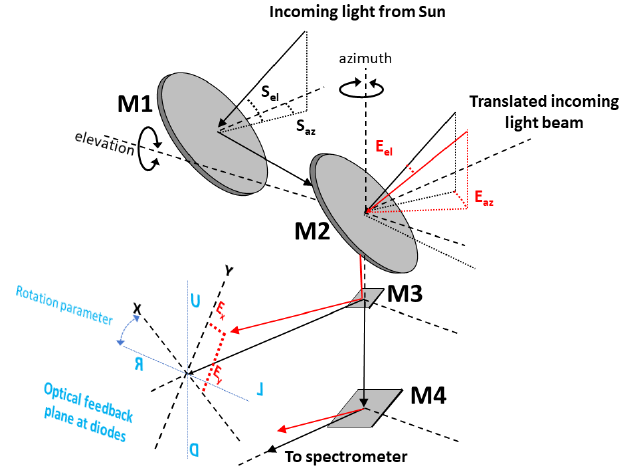
Figure 4. Geometry of the Lauder solar tracker optics for the sim- plest configuration. Focus optics are not shown. M1 and M2 are the tracker ALT-AZ mirrors. M3 is a small flat mirror to direct a por- tion of the incoming beam to the optical feedback system. M4 is a large flat mirror directing the solar beam into the spectrometer. ( Sel , Saz ) is the calculated (solar-pointing) incoming beam vector. X – Y is the planar coordinate system of the optical feedback sys- tem, shown here prior to correction with the installation-specific ro- tation parameter. ( Ex , Ey ) is the mispointing vector. ( Eel , Eaz ) is the mispointing vector transformed into the tracker vector reference